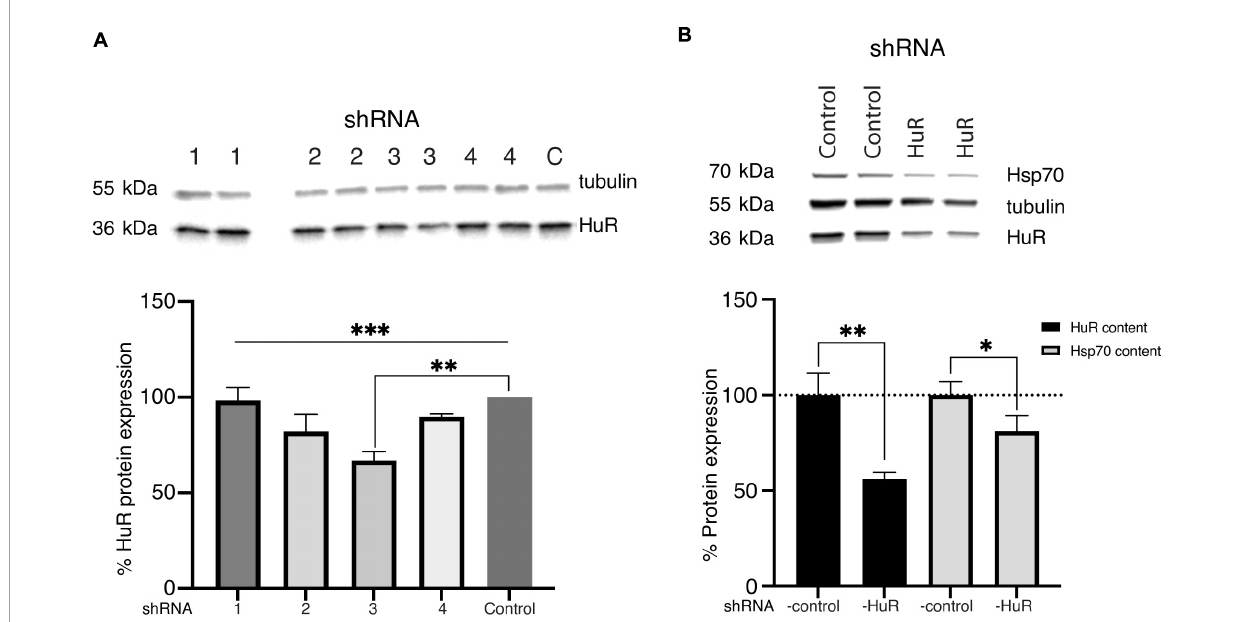
FIGURE1 Validation of the shRNA constructs. (A) Western blot analysis (two biological replicates for each group) and representative images of the total HuR protein content in B-35 cell homogenates transfected with different shRNA-HuR constructs (Nuschke et al., 2015; Fan et al., 2019; Nakazawa and Fukuchi, 2020; Vernazza et al., 2021). Based on analysis, the construct sh3 showed the most silencing potency expressed as lowest HuR protein content. C—shRNA-control, ∗∗∗ p < 0.003. ∗∗ p < 0.01. (B) Western blot analysis (two biological replicates for each group) of the silencing efficacy of the sh3RNA-HuR (sh3-GCAGAAGAGGCAATTACCAGT) construct; shRNA Control–cells after shRNA-scrambled control transfection, shRNA HuR–cells after shRNA-HuR transfection. The silencing potency was analyzed as the total HuR and Hsp70 protein contents in B35 cell homogenates following transfection. ∗∗ p < 0.01; ∗ p <